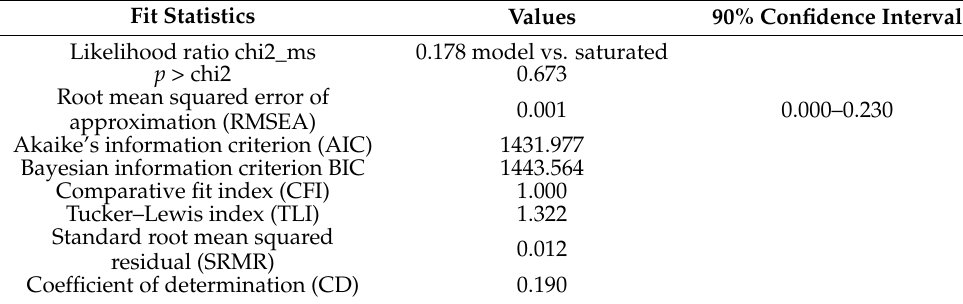
Table 6. Predictive model for resilience. Goodness of fit